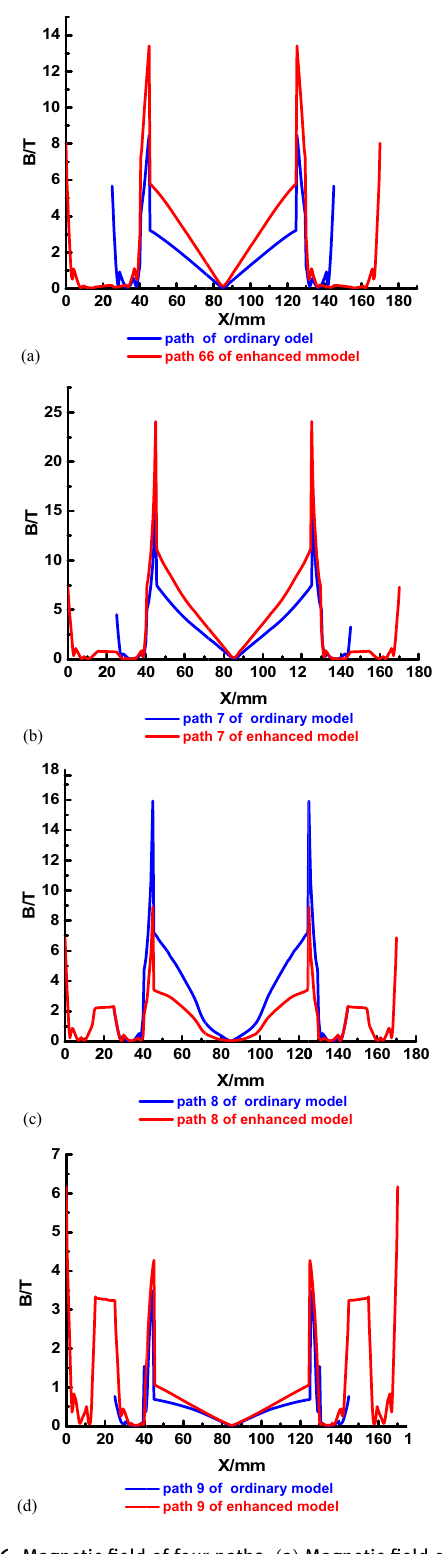
Figure 16: Magnetic fi eld of four paths. ( a ) Magnetic fi eld of path 6, ( b ) magnetic fi eld of path 7, ( c ) magnetic fi eld of path 8, and ( d ) magnetic fi eld of path